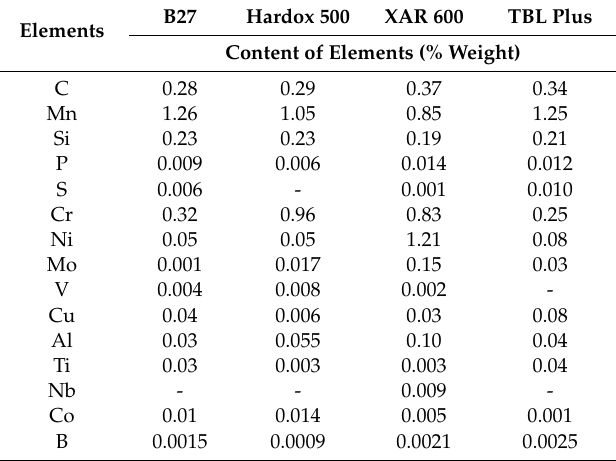
Table 1. Chemical composition of the tested materials.